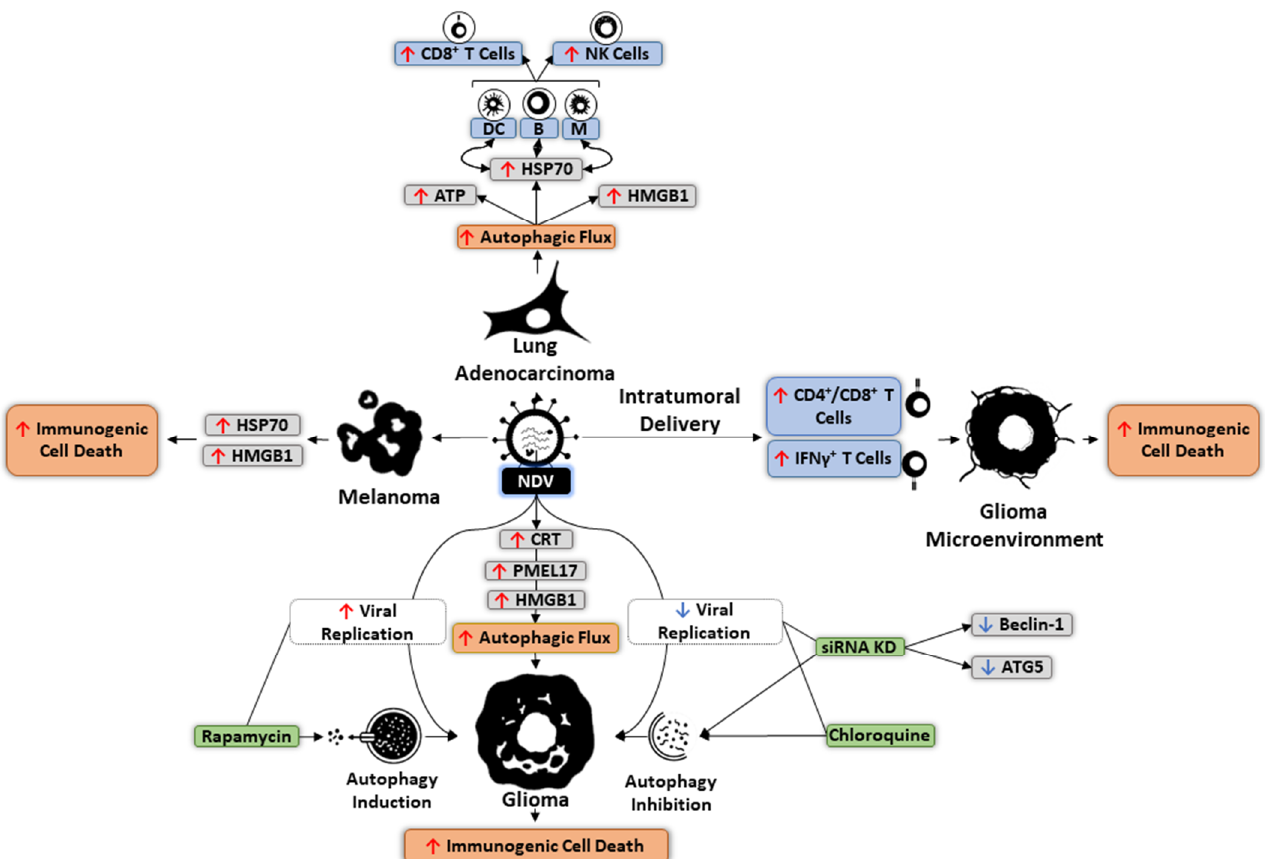
Figure 5. Induction of immunogenic cell death by Newcastle disease virus (NDV)-modulated autophagy. In lung adeno- carcinoma cells, increased level of autophagy following NDV entry upregulates HSP70, which mediates interactions